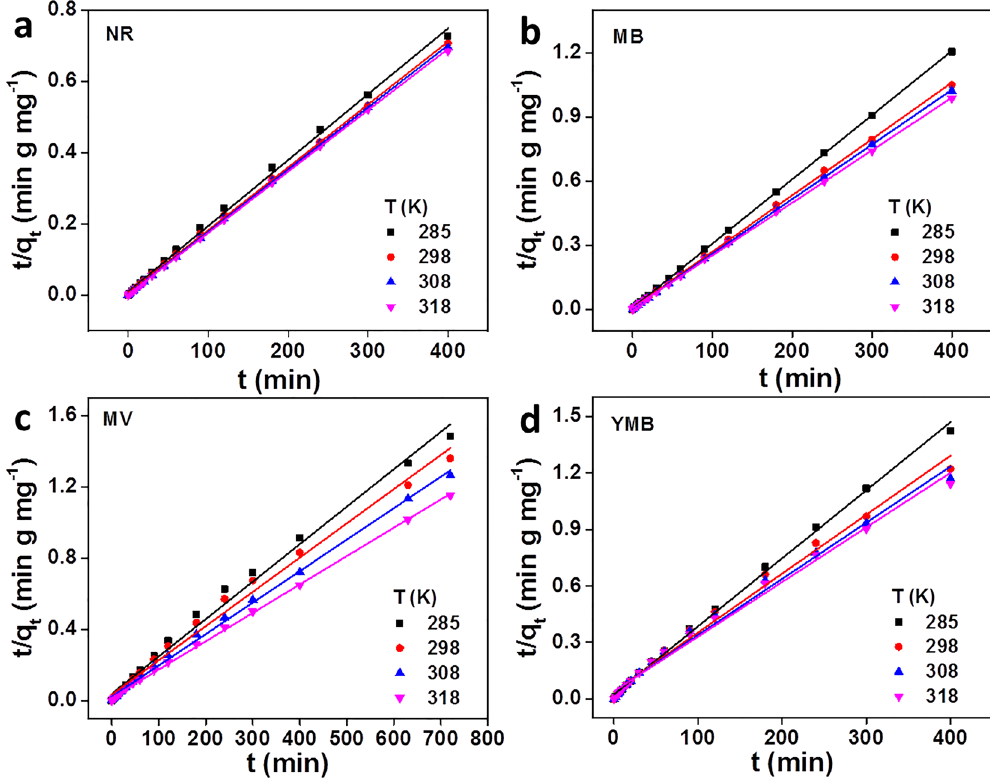
Figure 2. Modeling of the adsorption kinetics of ( a ) NR, ( b ) MB, ( c ) MV and ( d ) YMB using pseudo-second- order models onto PAAM/PA/PDA hydrogel.